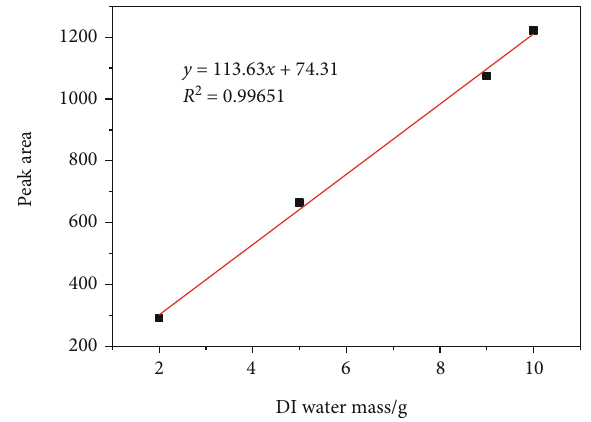
Figure 3: The conversion relationship between peak area and water content in bentonite. Line is the linear fi